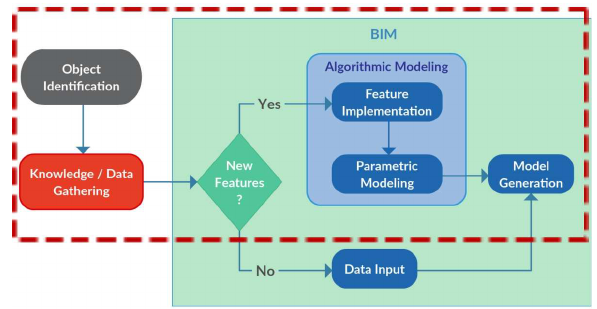
Figure 7. Visual Coding for features implementation